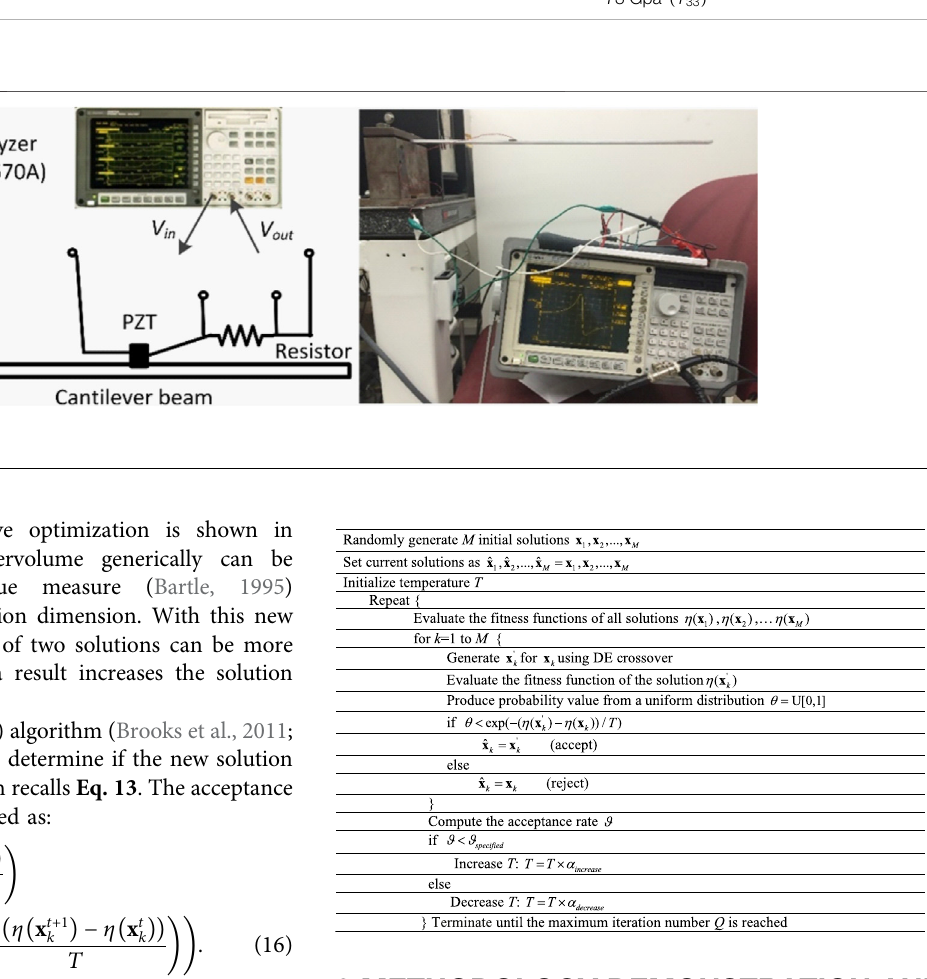
Figure 2 . A resistor of 100 Ω is connected in series with the piezoelectric transducer to measure the voltage drop ( Figure 2 ).